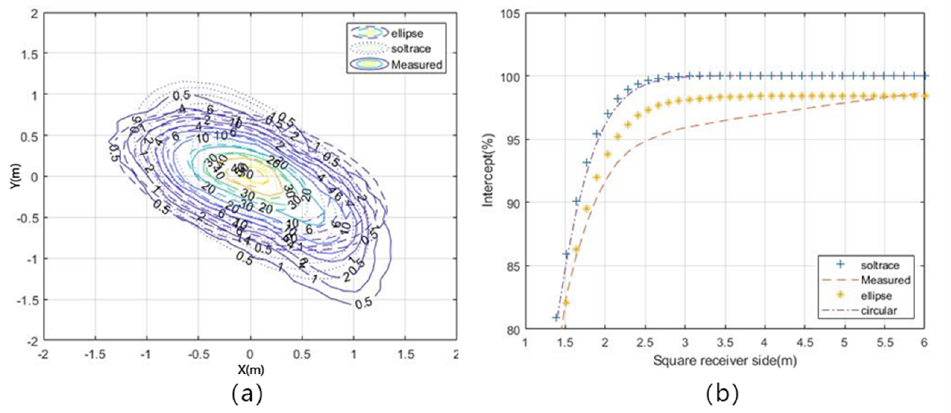
Figure 15. ( a ) Contours of the measured and computed flux distribution (kW/m 2 ): Heliostat #9, ( b ) measured and computed intercepts vs. the side length of a square receiver: Heliostat #9